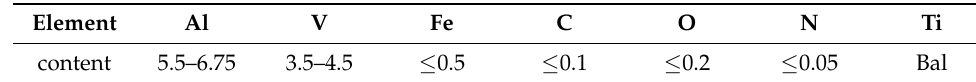
Table 1. The composition of Ti-6Al-4V.